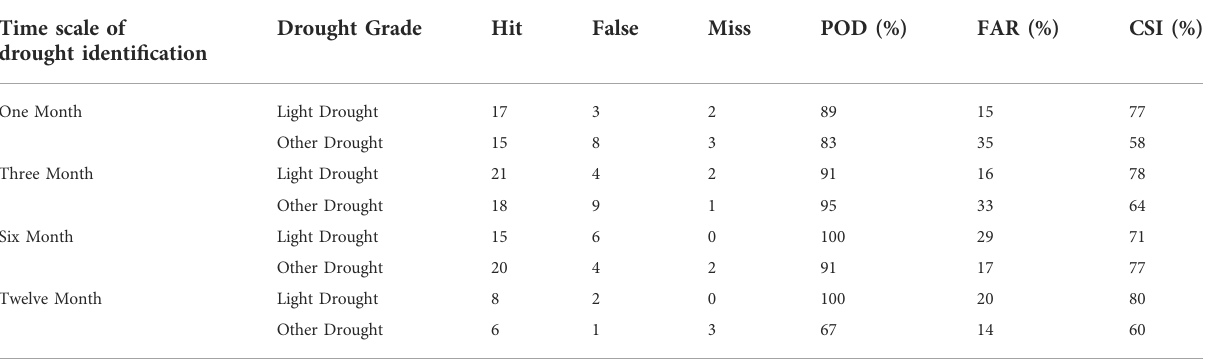
TABLE 5 Detection effect on speci fi c drought